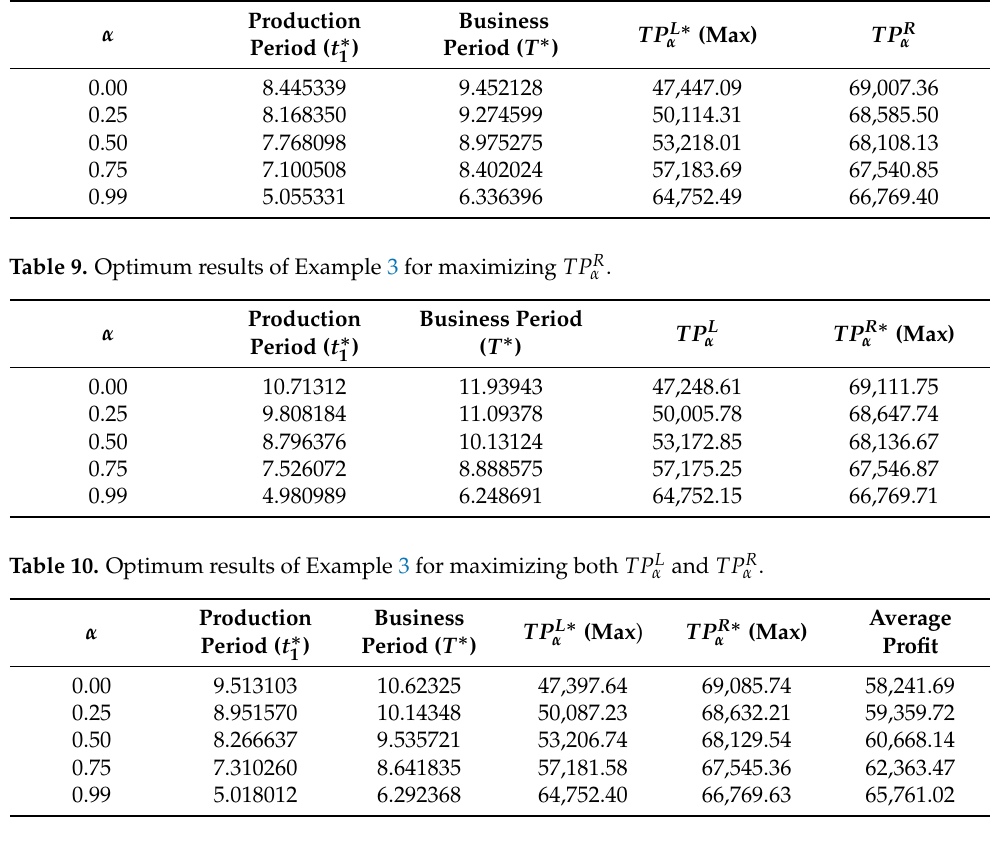
Table 8. Optimum results of Example 3 for maximizing TP L α .